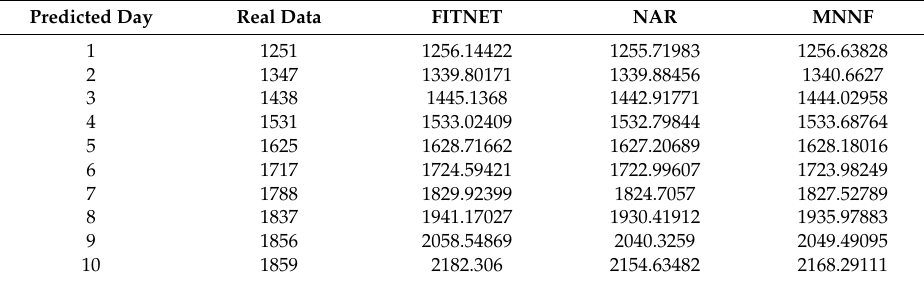
Figure 9. Death cases in Mexico and prediction. Table 3. Predicted death cases in 10 days for Mexico.